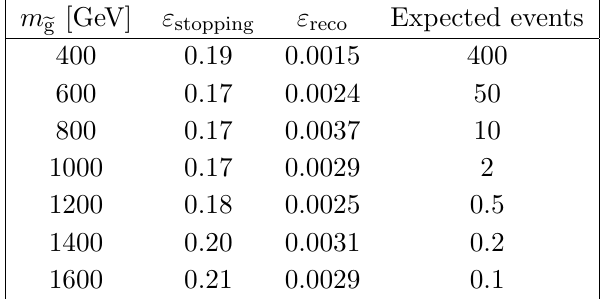
Table 2 . Gluino " stopping and " reco , as well as the number of expected gluino events with lifetimes between 10 (cid:22) s and 1000 s, assuming B (